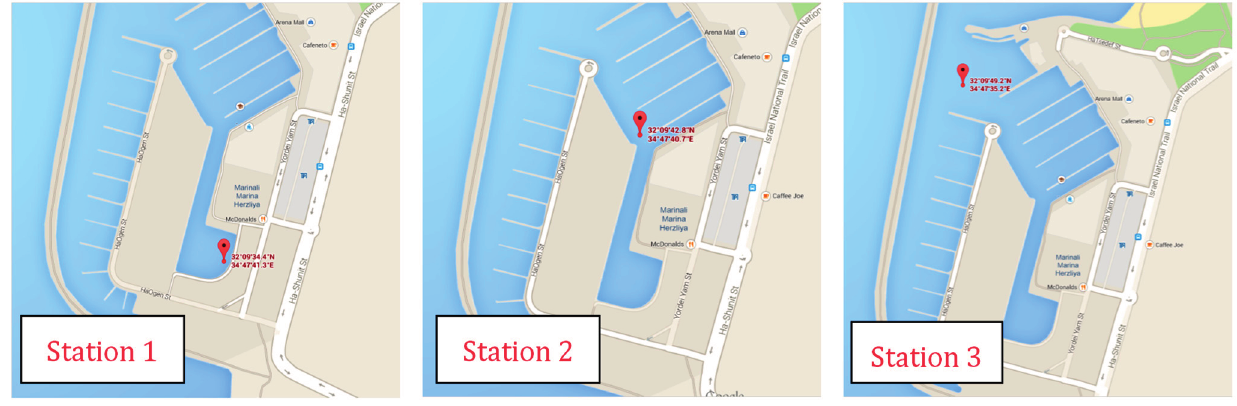
Figure 11. Geographical position of Stations 1, 2 and 3 in Herzliya